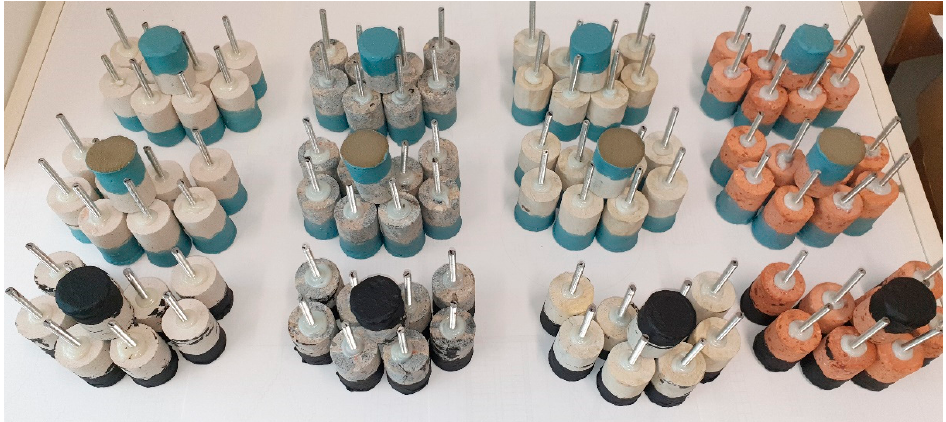
Figure 7. Finished set of specimens with the applied waterproofing screed. Three sets of specimens were created, each set with different boundary conditions.